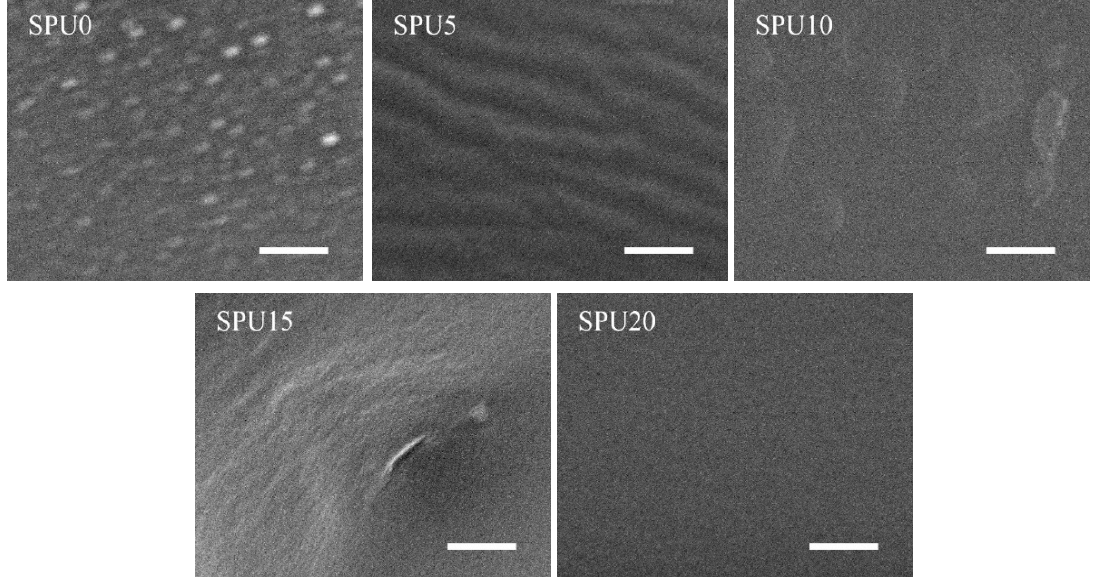
Figure 10. SEM micrographs of the surfaces of SPU films (scale bar = 10 µm).